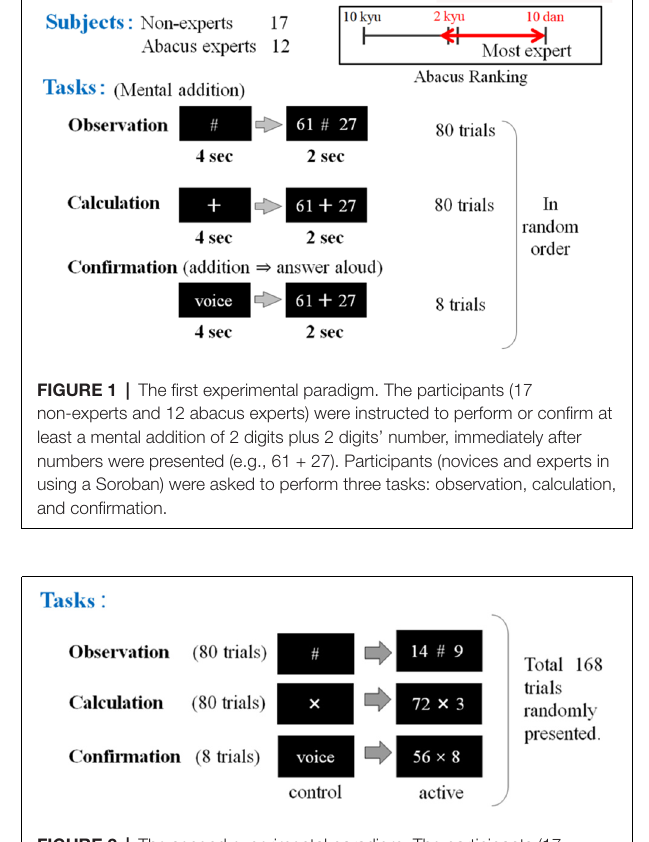
FIGURE 2 | The second experimental paradigm. The participants (17 non-experts and 13 abacus experts) were instructed to perform, observe, or confirm some arithmetic operations by multiplying a two-digit number by a one-digit number (e.g., 72 × 3), immediately after numbers were presented. Participants (novices and experts in using a Soroban) were asked to perform three tasks: calculation, observation, and confirmation. “X” means the execution of mental calculation and “#” means just observation of numbers.